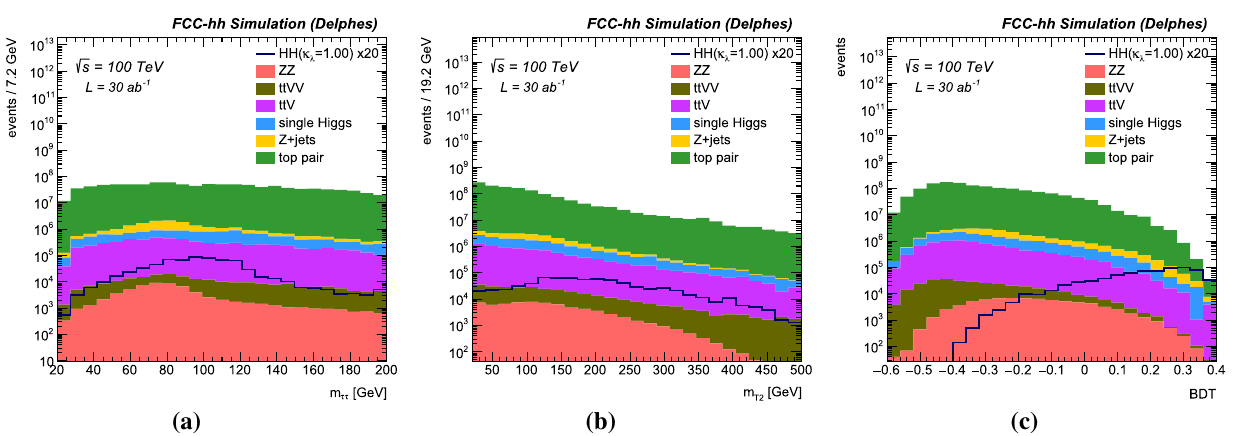
Fig. 8 Distributions in the b ¯ b τ h τ h final state of the invariant mass of the ττ pair (left), m T2 (center), and output of the BDT multi-variate discriminant (right)